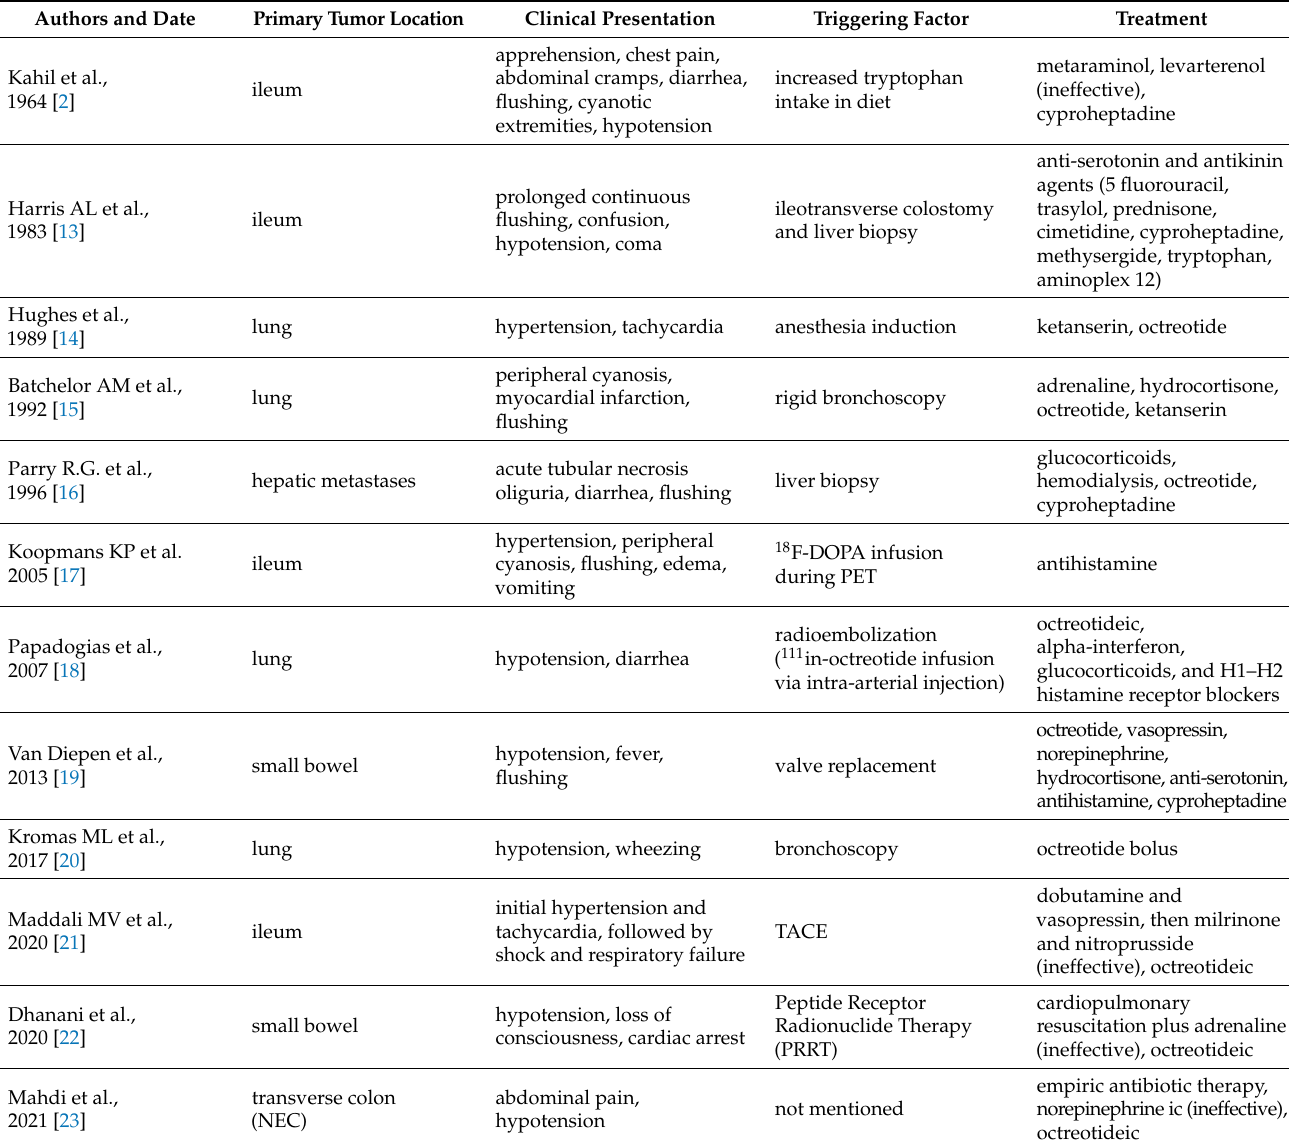
Table 1. Case reports of Carcinoid Crisis up to September